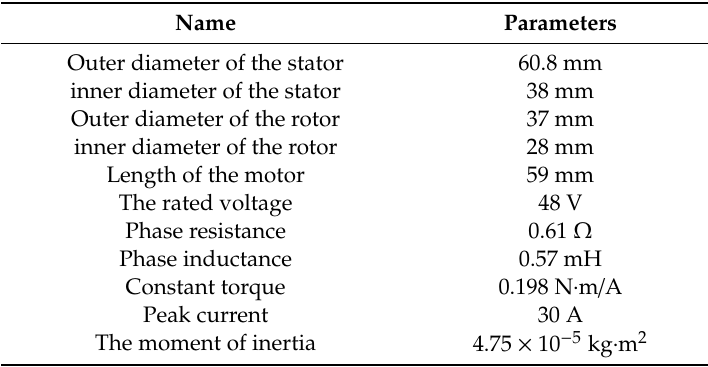
Table 1. Main parameters of the